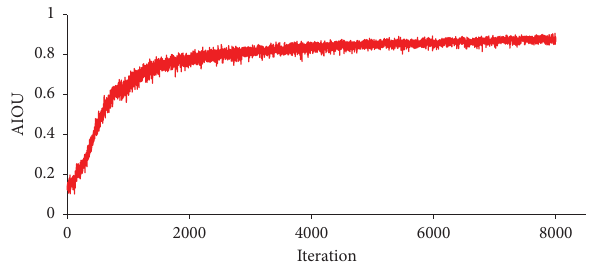
Figure 7: The iterative convergence process of the AIOU curve for YOLOv2 network training.